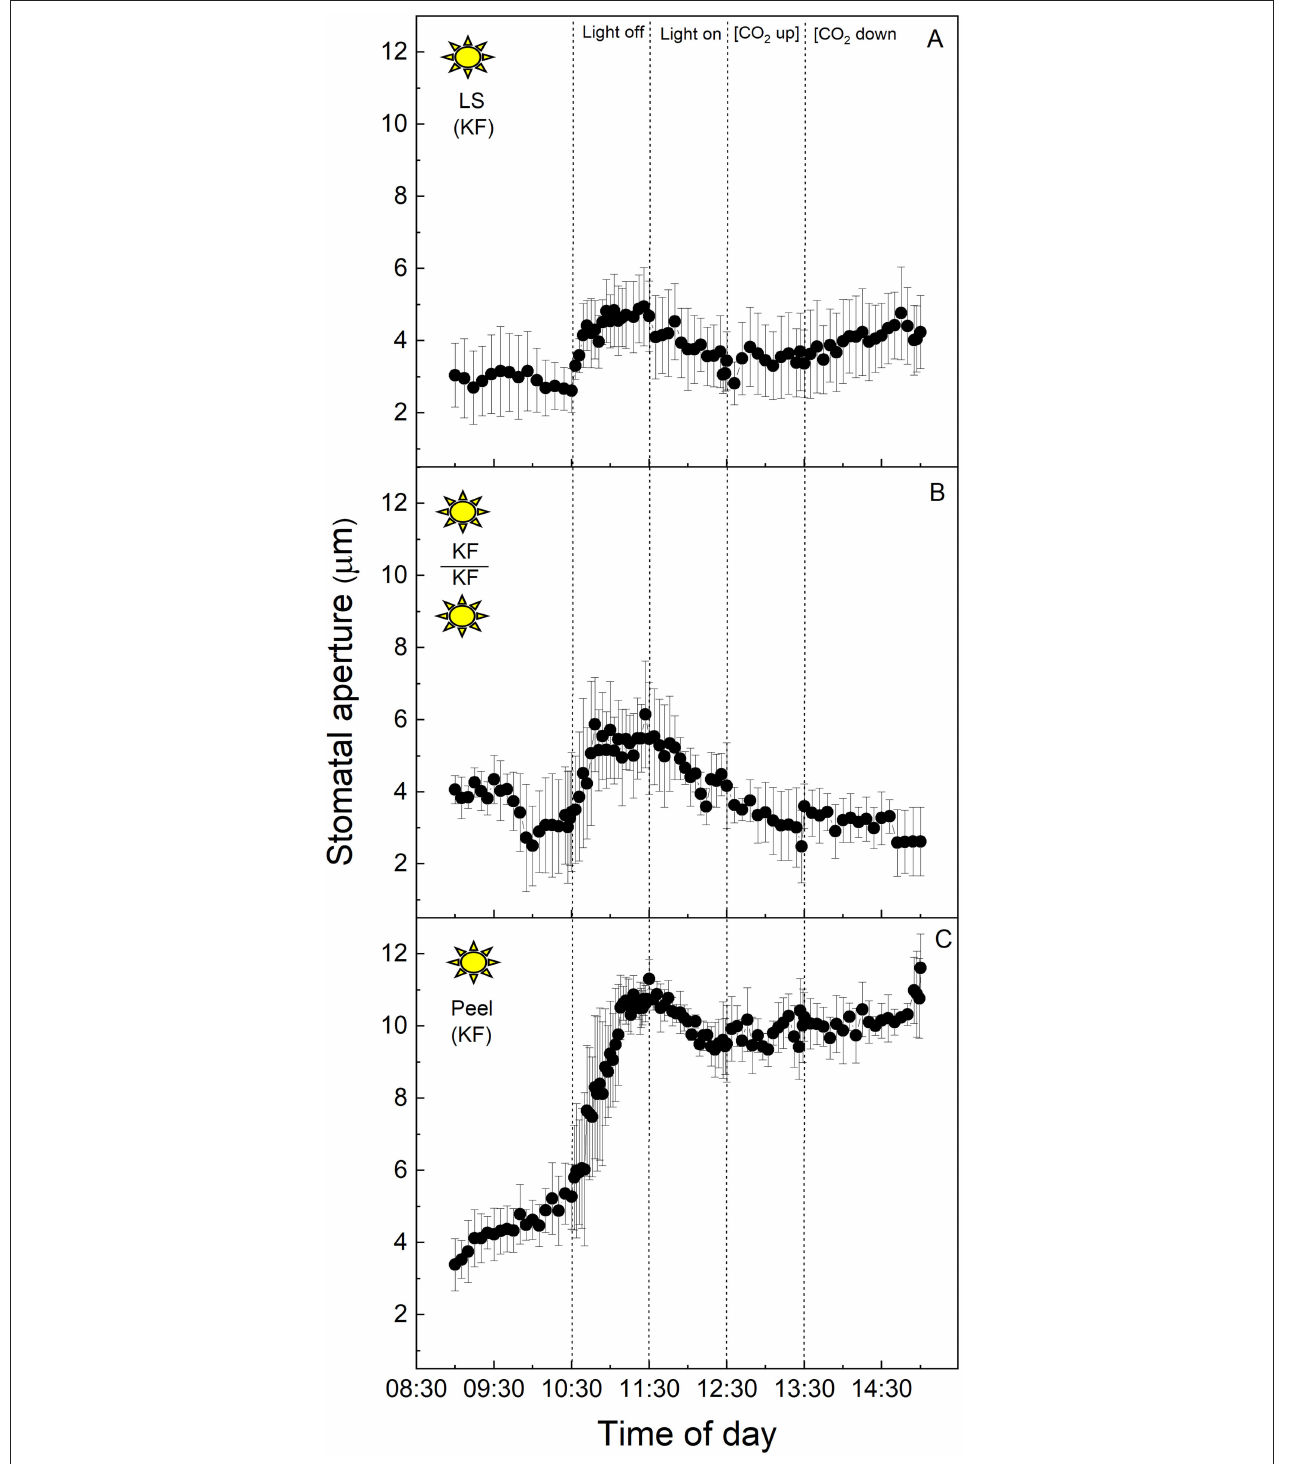
FIGURE 2 | (A) Kalanchoë fedschenkoi leaf segment; (B) Abaxial peeled epidermis of Kalanchoë fedschenkoi leaf on abaxial exposed mesophyll of Kalanchoë fedschenkoi , from the “light” growth chamber; (C) Abaxial isolated epidermis of Kalanchoë fedschenkoi leaf, from “light” growth chamber (light period 8:00a.m. to 8:00 p.m.). Light intensity was changed from photon flux density of 400 ± 10 µ mol m − 2 s − 1 to darkness, as indicated, and [CO 2 ] was changed from 120 to 650 µ mol mol − 1 , as indicated. The temperature of the chamber was maintained at 23 ± 1 ◦ C. The values are means of four repetitions ( ± SE). The sun symbol represents plants taken from the light-grown